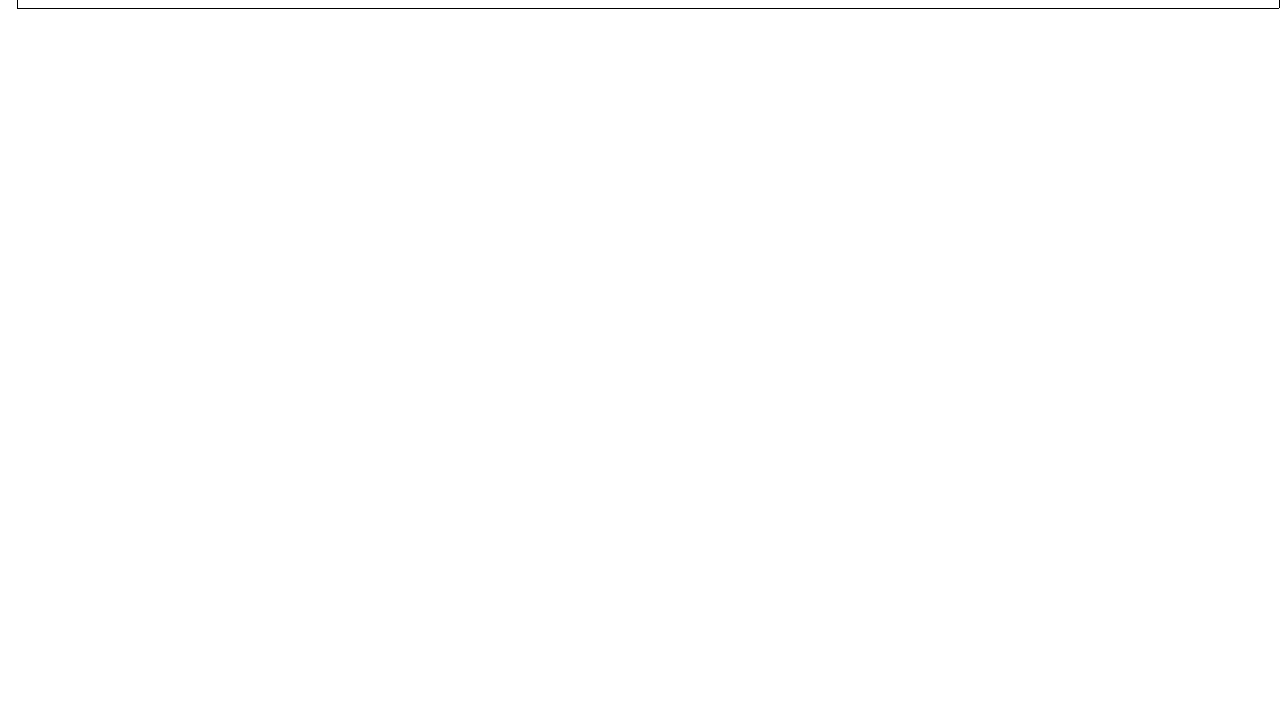
for pmo), amino acid synthesis, cell wall synthesis, translation, transcription, DNA replication, and tRNA